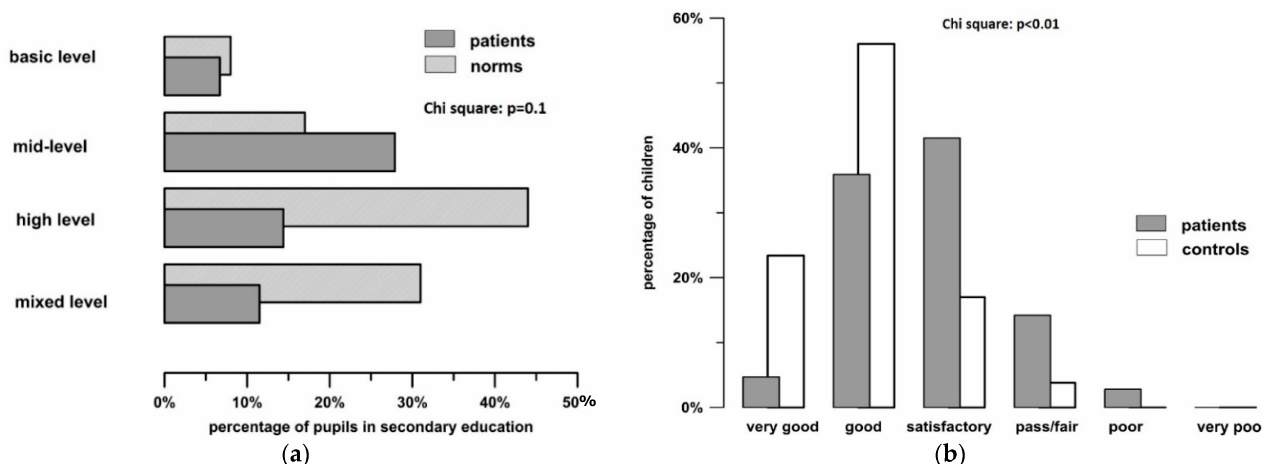
Figure 2. ( a ) Comparison of type of secondary schooling between transplanted patients and norms. Norm data in this figure are drawn from official German census data from 2016 including all children visiting secondary schooling in Germany. Patients are depicted by grey bars, and norm data is depicted by hatched bars. ( b ) School performance of patients (shaded bars) compared to controls (white bars) as rated by their